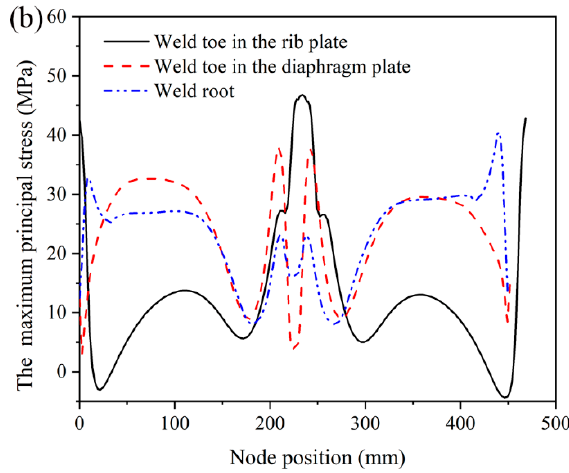
Figure 14. ( a ) Reinforcing plates in improvement scheme 2 and ( b ) stress—node position curves of the rounded welding region.